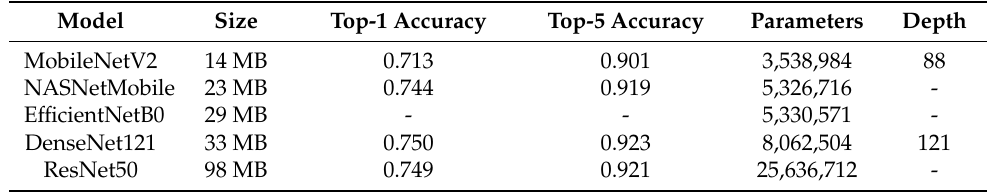
Table 8. Small Size Keras Applications Using the ImageNet Dataset